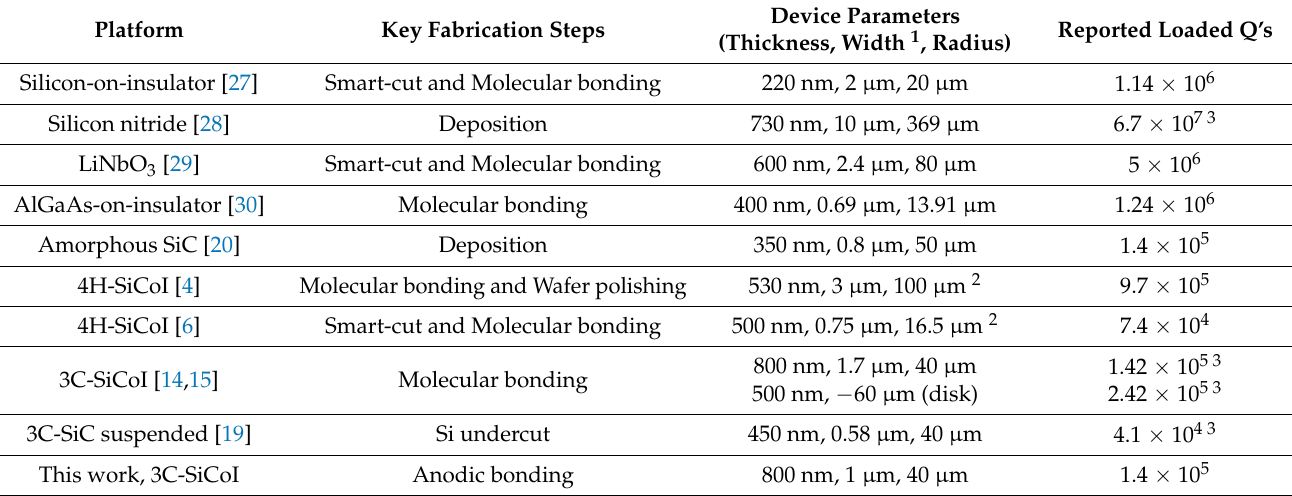
Table 1. A summary of different platforms for integrated